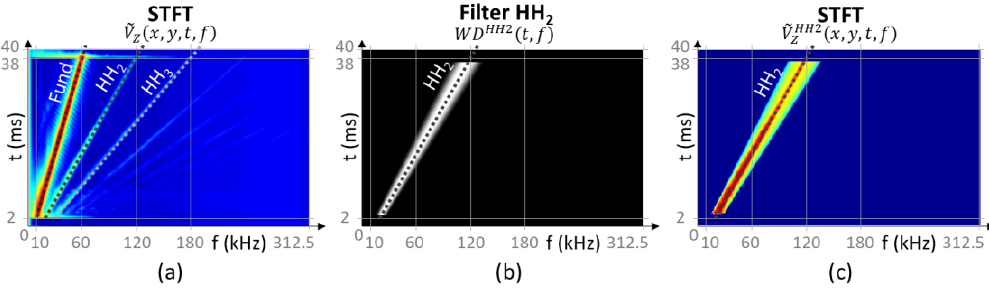
Figure 4. Extraction of the second higher harmonic component HH2 for the test specimen with artificial delaminations: ( a ) Average short-time Fourier transform of the measured out-of-plane velocity response, ( b ) Bandpass filter around the HH2 curve, ( c ) Extracted HH2 component in time-frequency domain.